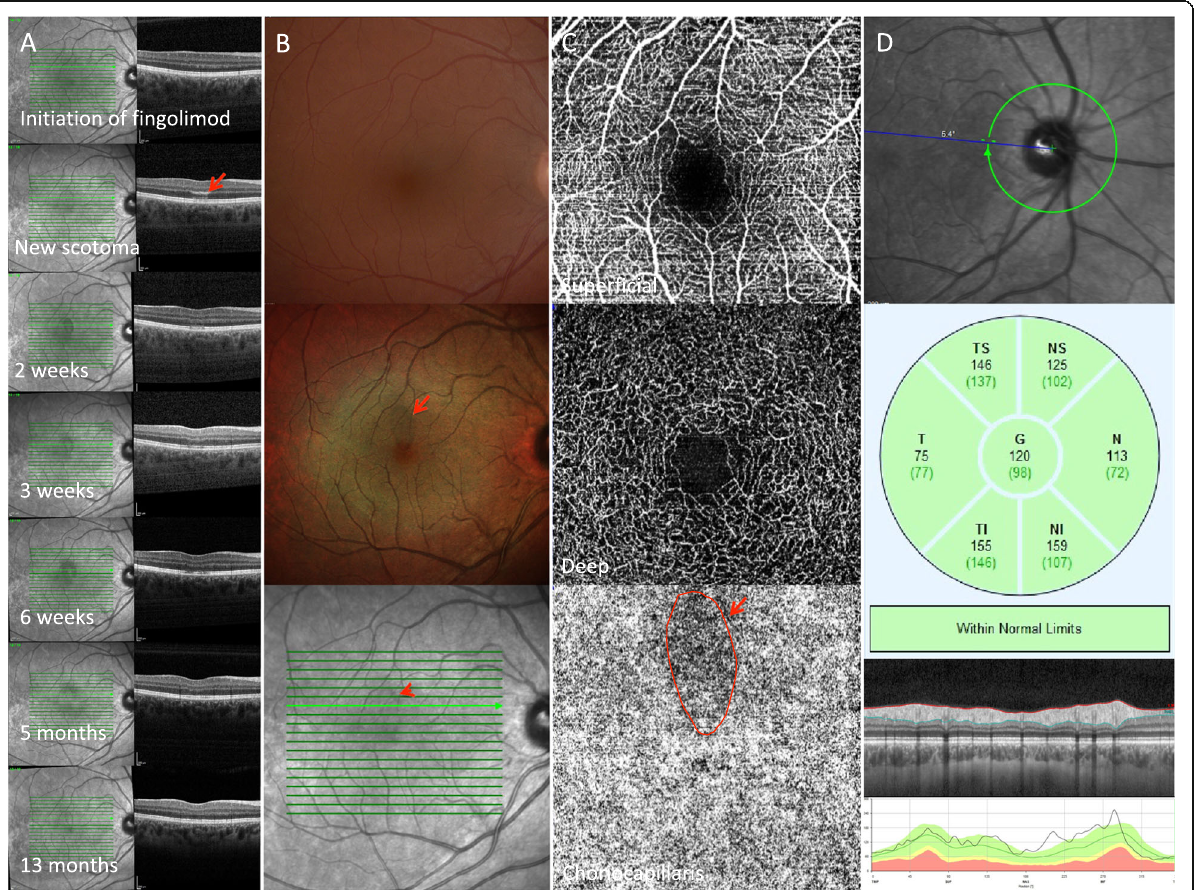
Fig. 2 A 27 yo female on fingolimod developed Acute Macular Neuroretinopathy (AMN) 5 months after initiating treatment. Optical coherence tomography (OCT) reveals natural history of AMN, seen as hyperreflectivity of the outer plexiform layer with secondary involvement of the ellipsoid layer and external limiting membrane ( a ) Subtle reddish parafoveal lesion is shown on color fundus image yet better visualized as a petalloid lesion with multicolor imaging ( b ) Choriocapillaris OCT angiography shows a filling defect ( c ) Retinal nerve fiber layer OCT is within normal limits ( d